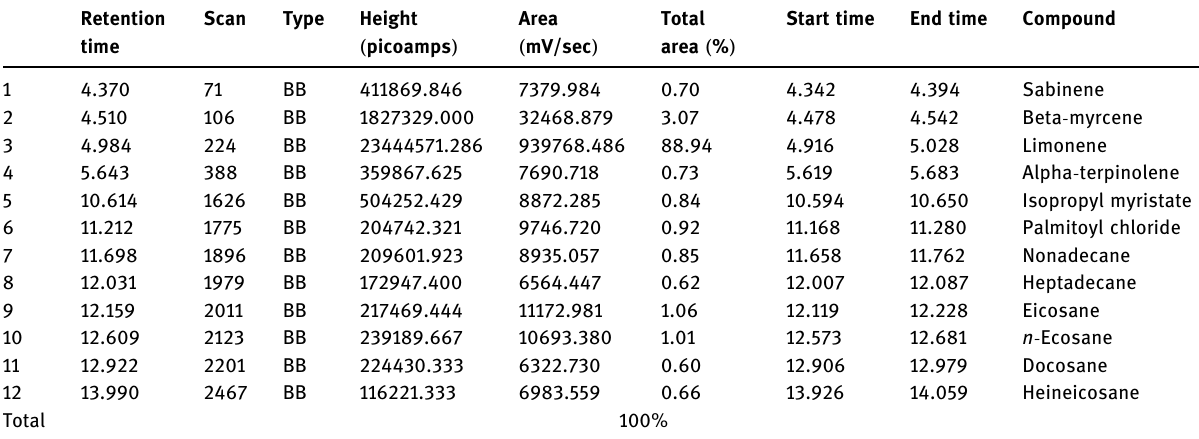
Table 1: Phytochemical compounds identi fi ed in C. sinensis EO Retention